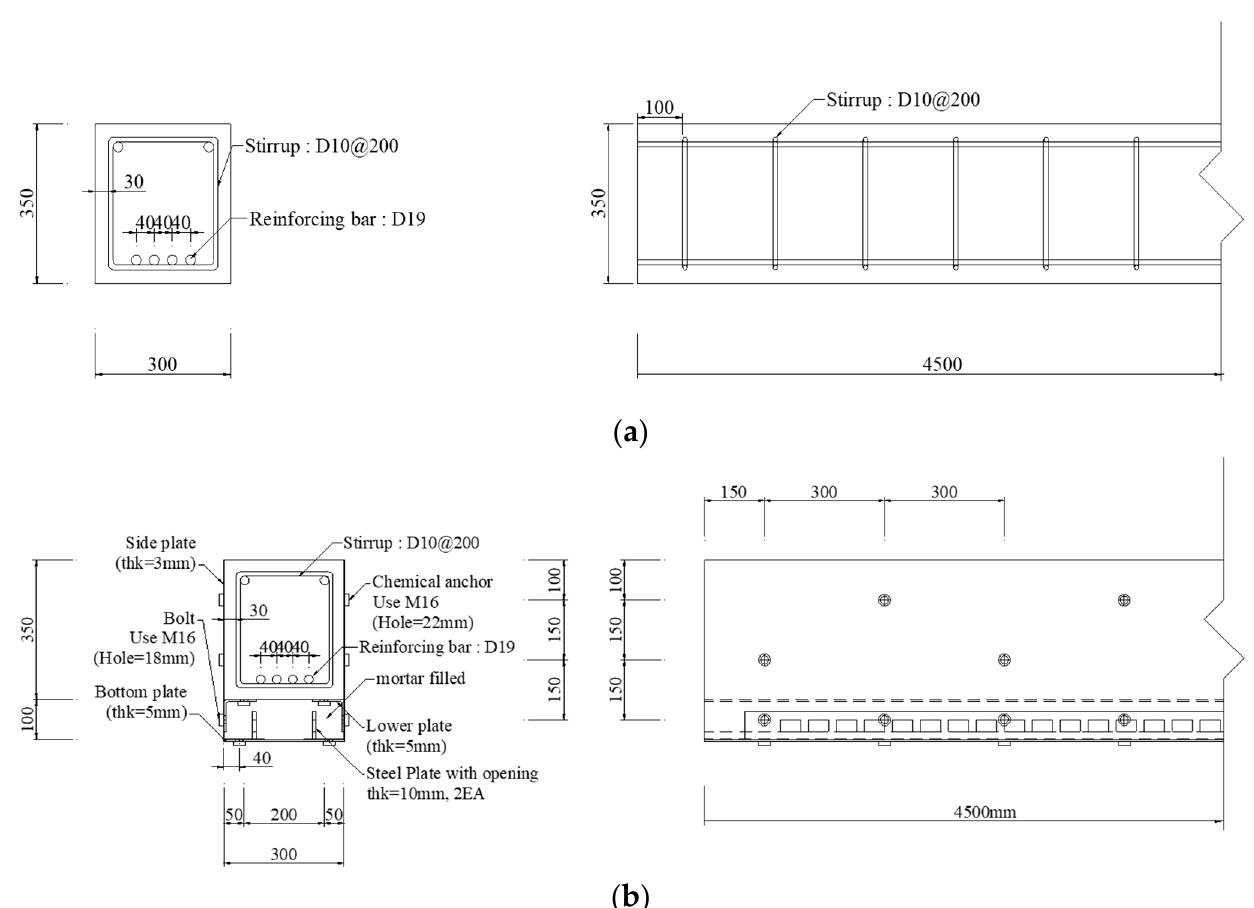
Figure 7. Specimen details: ( a ) RC; ( b ) D100-A2 .